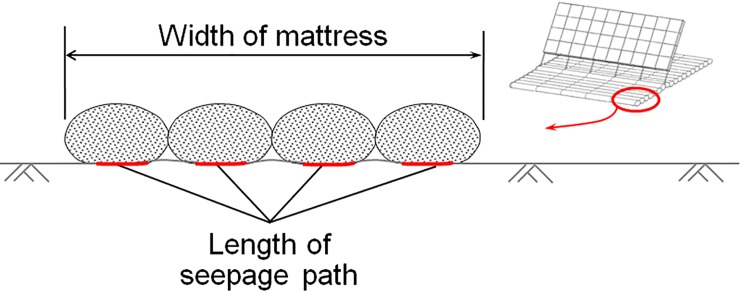
Schematic diagram for the mattress width and the seepage path under the mattress.